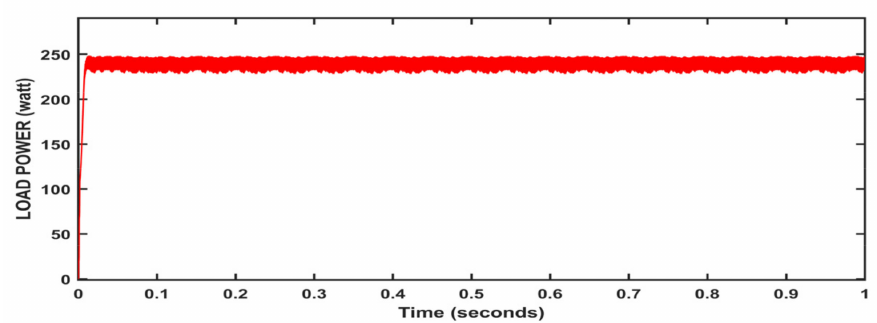
Figure 14. Algorithm performance under varying loads, and constant temperature and irradiation.